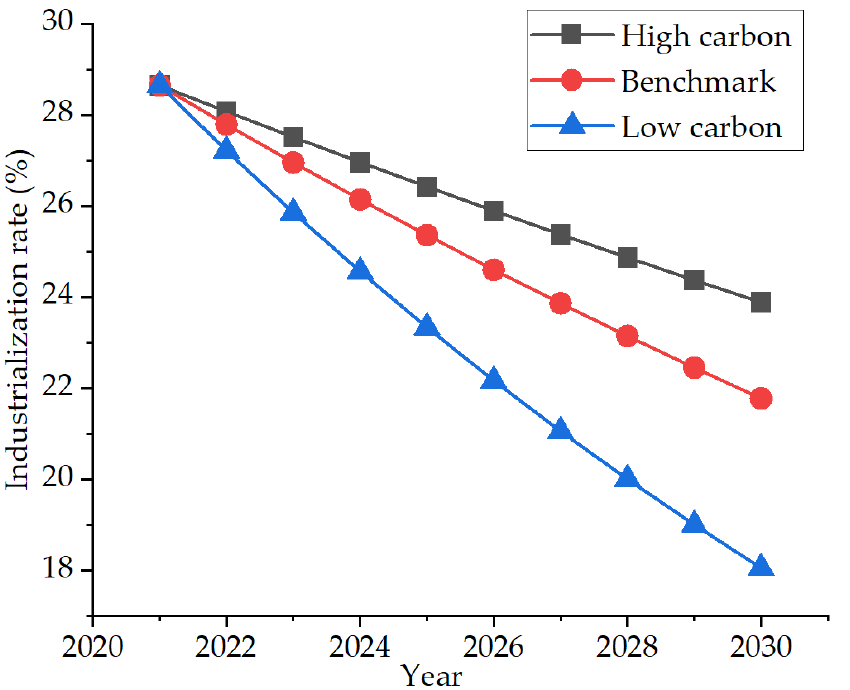
Figure 8. Three industrialization rate development scenarios.